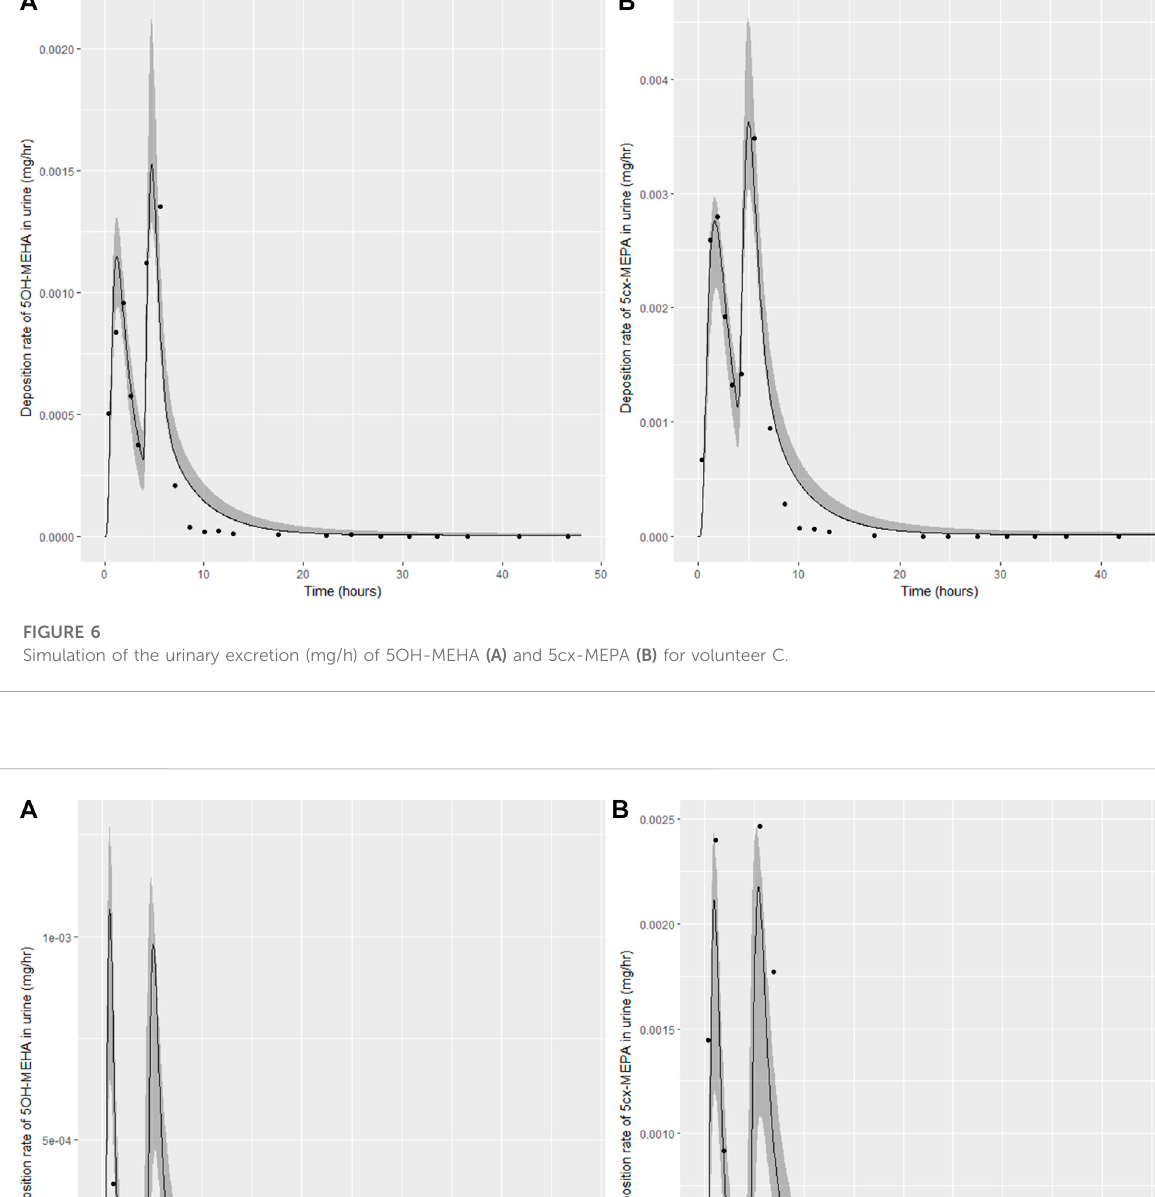
MEHA and 5cx-MEPA (mg/h) showed lower variability compared to panels A) and B), with all curves showing the appearance of a very rapid peak and a decay in deposition rate toward zero over the